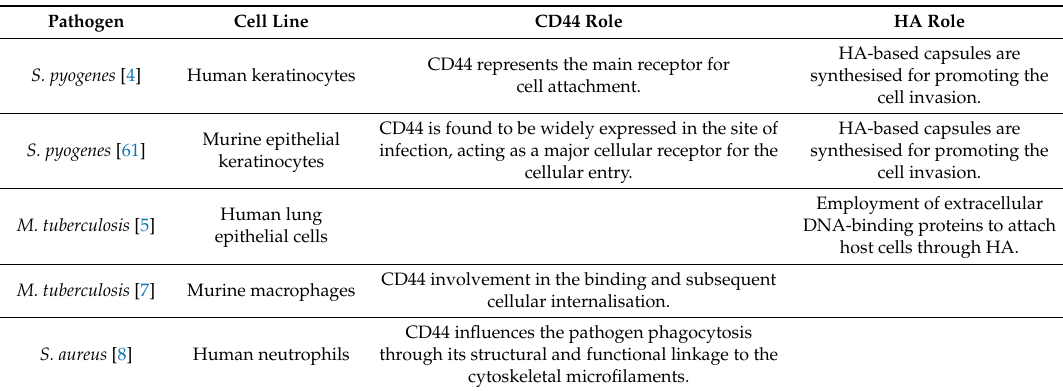
Table 1. CD44 and HA involvement in the host cell